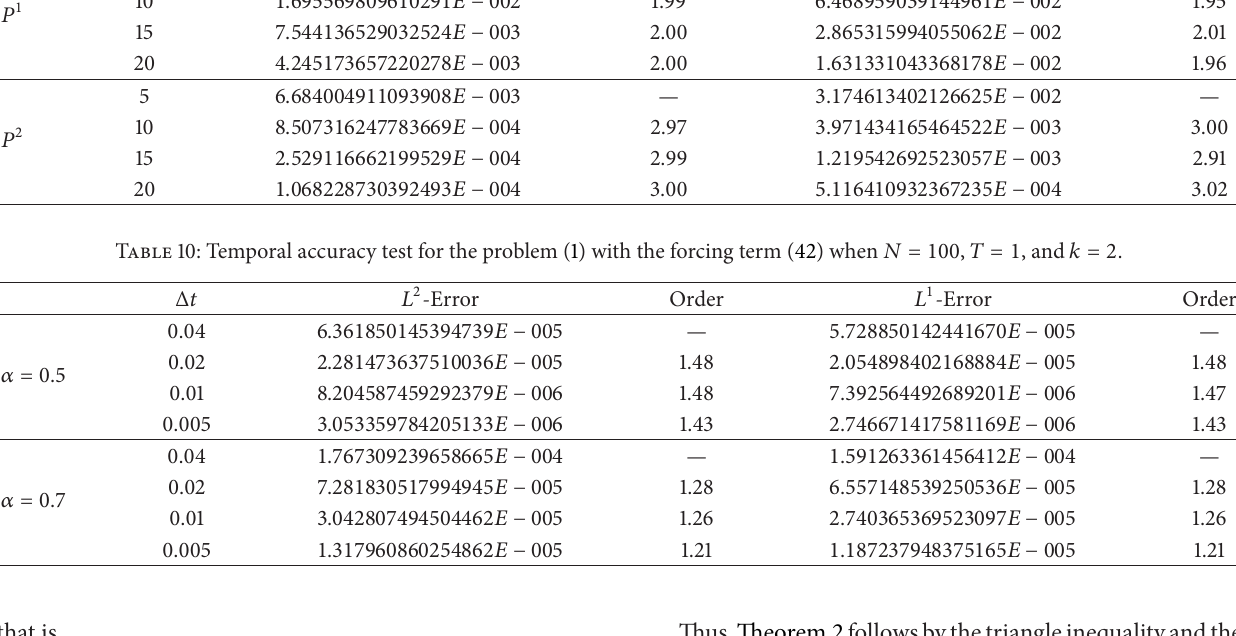
20 4.245173657220278𝐸 − 003 2.00 1.631331043368178𝐸 − 002 1.96